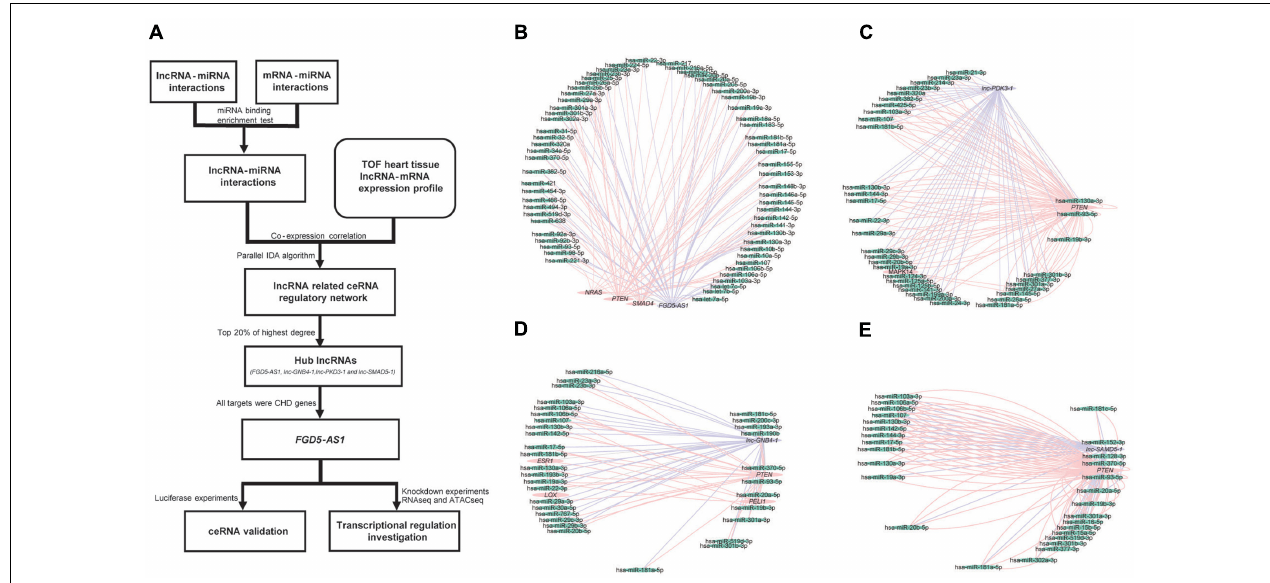
FIGURE 1 | Workflow of the entire study and the competing endogenous RNA (ceRNA) regulatory networks of each hub long non-coding RNA (lncRNA) in tetralogy of Fallot (TOF) hearts. (A) The workflow for the entire study. (B–E) The four networks all contain three types of genes, namely lncRNAs ( purple ), mRNAs ( pink ), and miRNAs ( green ). The edges connected between nodes indicate their co-expression relationship. The networks of the four hub lncRNAs ( FGD5-AS1 , lnc-GNB4-1 , lnc-PDK3-1 , and lnc-SAMD5-1 ) are presented,